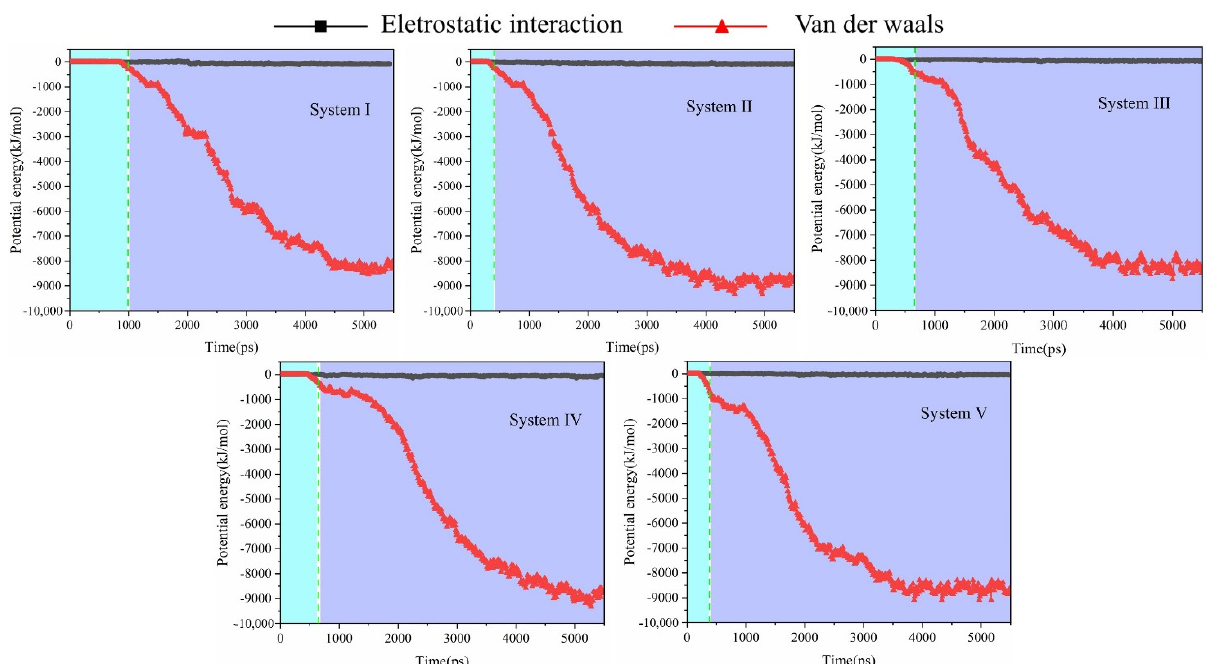
Figure 9. Interaction energy and its decomposed composition between two oil droplets during simulation.